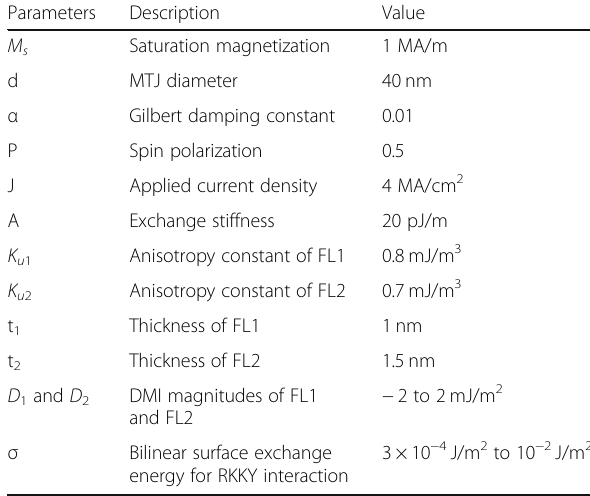
Table 1 Parameters used in simulation